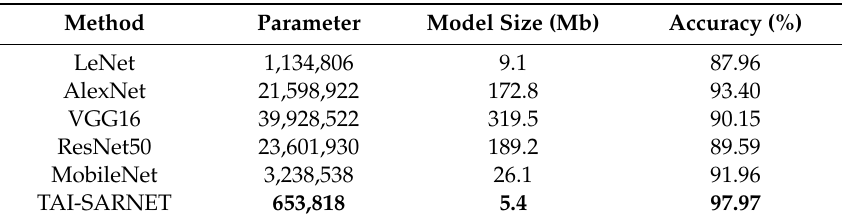
Table 8. Performance comparison with other classical networks.